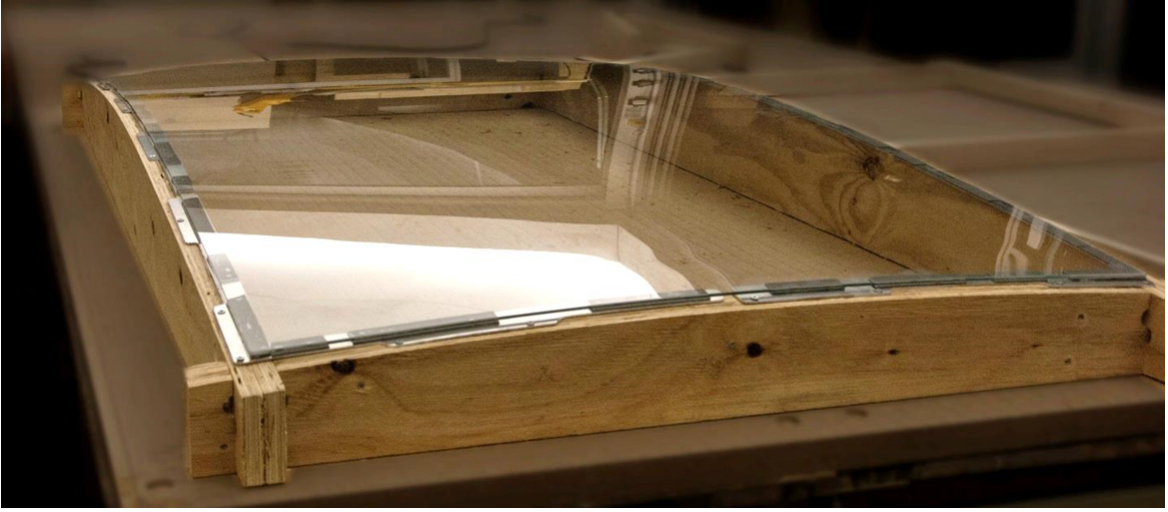
Fig. 9 Second synclastic double-curvature